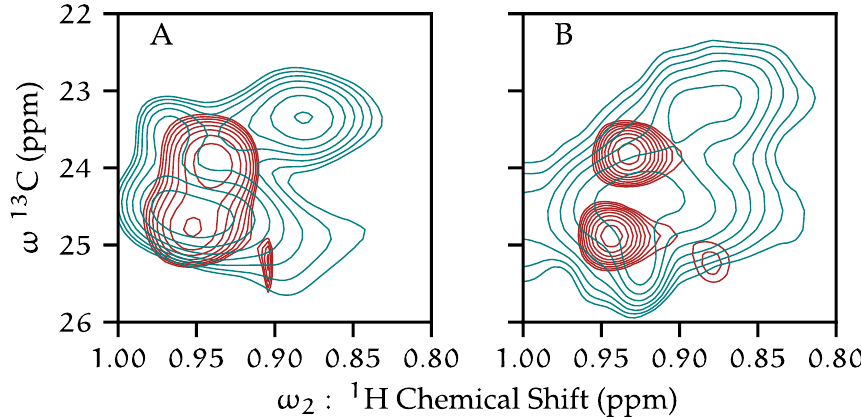
Figure 5. 1 H- 13 C HSQC spectra of leucine H δ of KcsA in liposomes. pH 7.25 (red contours) and pH 4.0 (turquoise contours) are shown, with fully protonated KcsA samples ( A ) and fractionally deuterated KcsA samples ( B ).